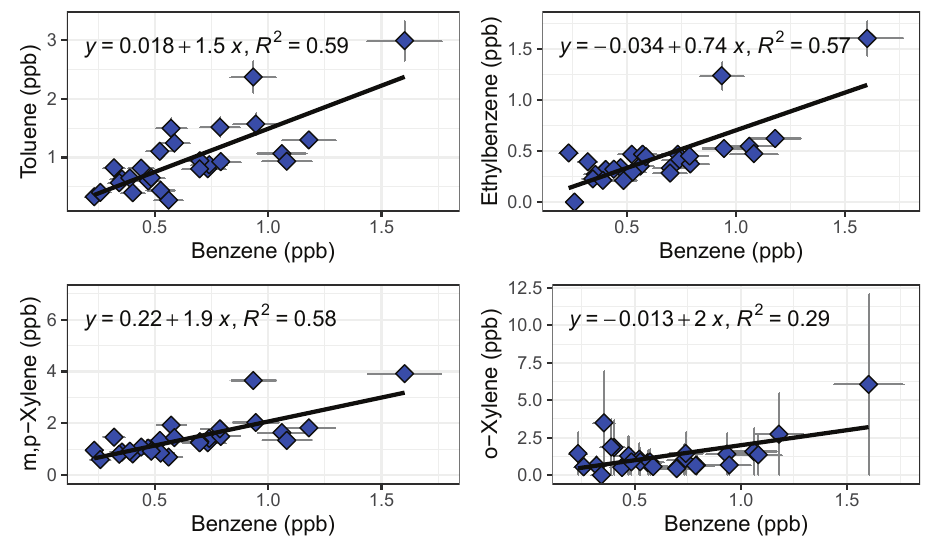
Figure 11. Benzene ratios for on-freeway emissions measured by GC1 and GC2 shown with a linear regression